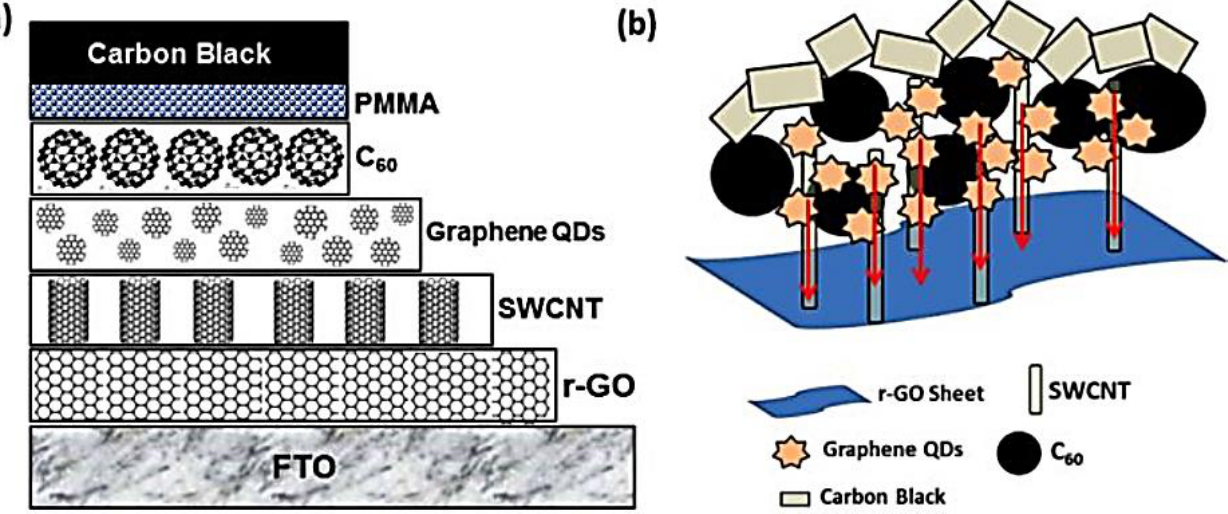
Figure 6. Schematic diagram of ( a ) sequential fabrication of solar cells using different allotropes of carbon and ( b ) probable arrangement of different allotropes used during sequential fabrication of carbon solar cells [78]. PMMA = poly(methyl methacrylate); QD = quantum dot; SWCNT = single-walled carbon nanotube; r-GO = reduced graphene oxide. Reproduced with permission from ACS. Table 1. Solar cell parameters of nanocarbon-based solar cells [78]. PMMA/C 60 = poly(methyl meth- acrylate)/fullerene C 60 ; PCE = photo-conversion efficiency; Jsc = short-circuit current density; Voc = open-circuit voltage; FF = fill factor. Reproduced with permission from ACS.